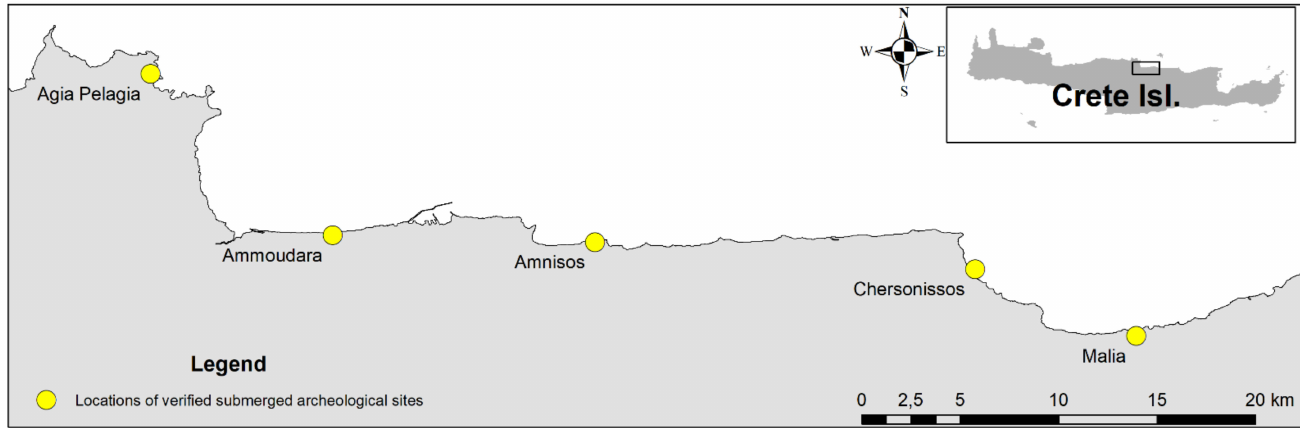
Figure 11. Locations of archeological sea level indicators in the proximity of Ammoudara